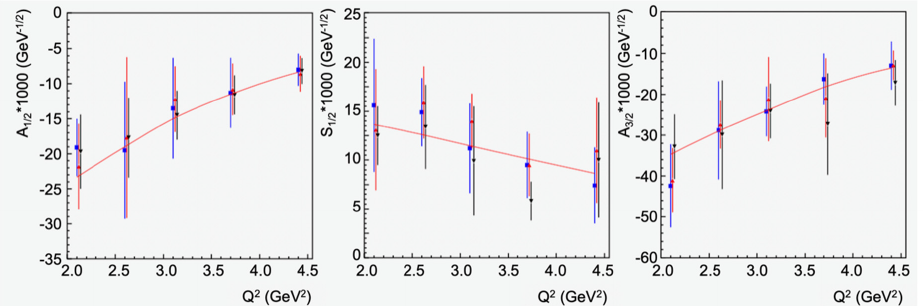
Figure 9. Preliminary ∆ ( 1600 ) 3/2 + electrocouplings with their assigned uncertainties, determined from independent analysis of the π + π − p differential cross sections in three overlapping W intervals: 1.46–1.56GeV (filled blue squares), 1.51–1.61GeV (filled red triangles), and 1.56–1.66 GeV (filled black triangles) [136,137,144]. CSM predictions [74] are drawn as solid red